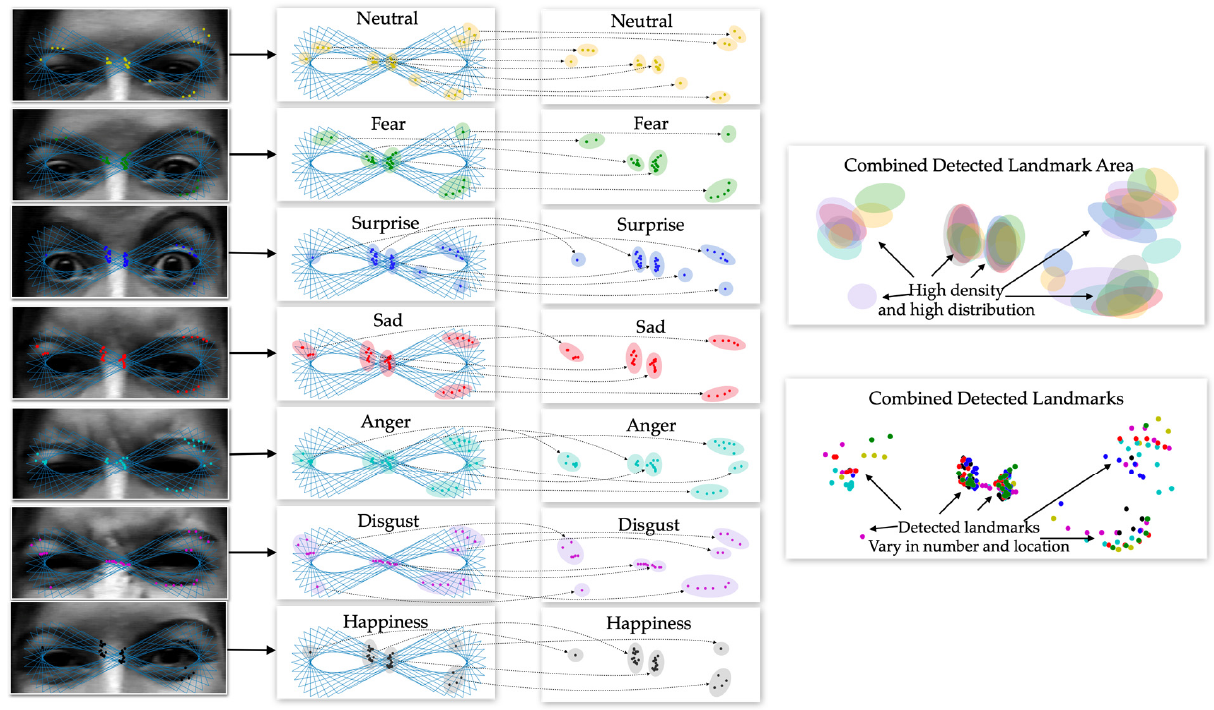
Figure 6. Landmarks detected using our proposed method.